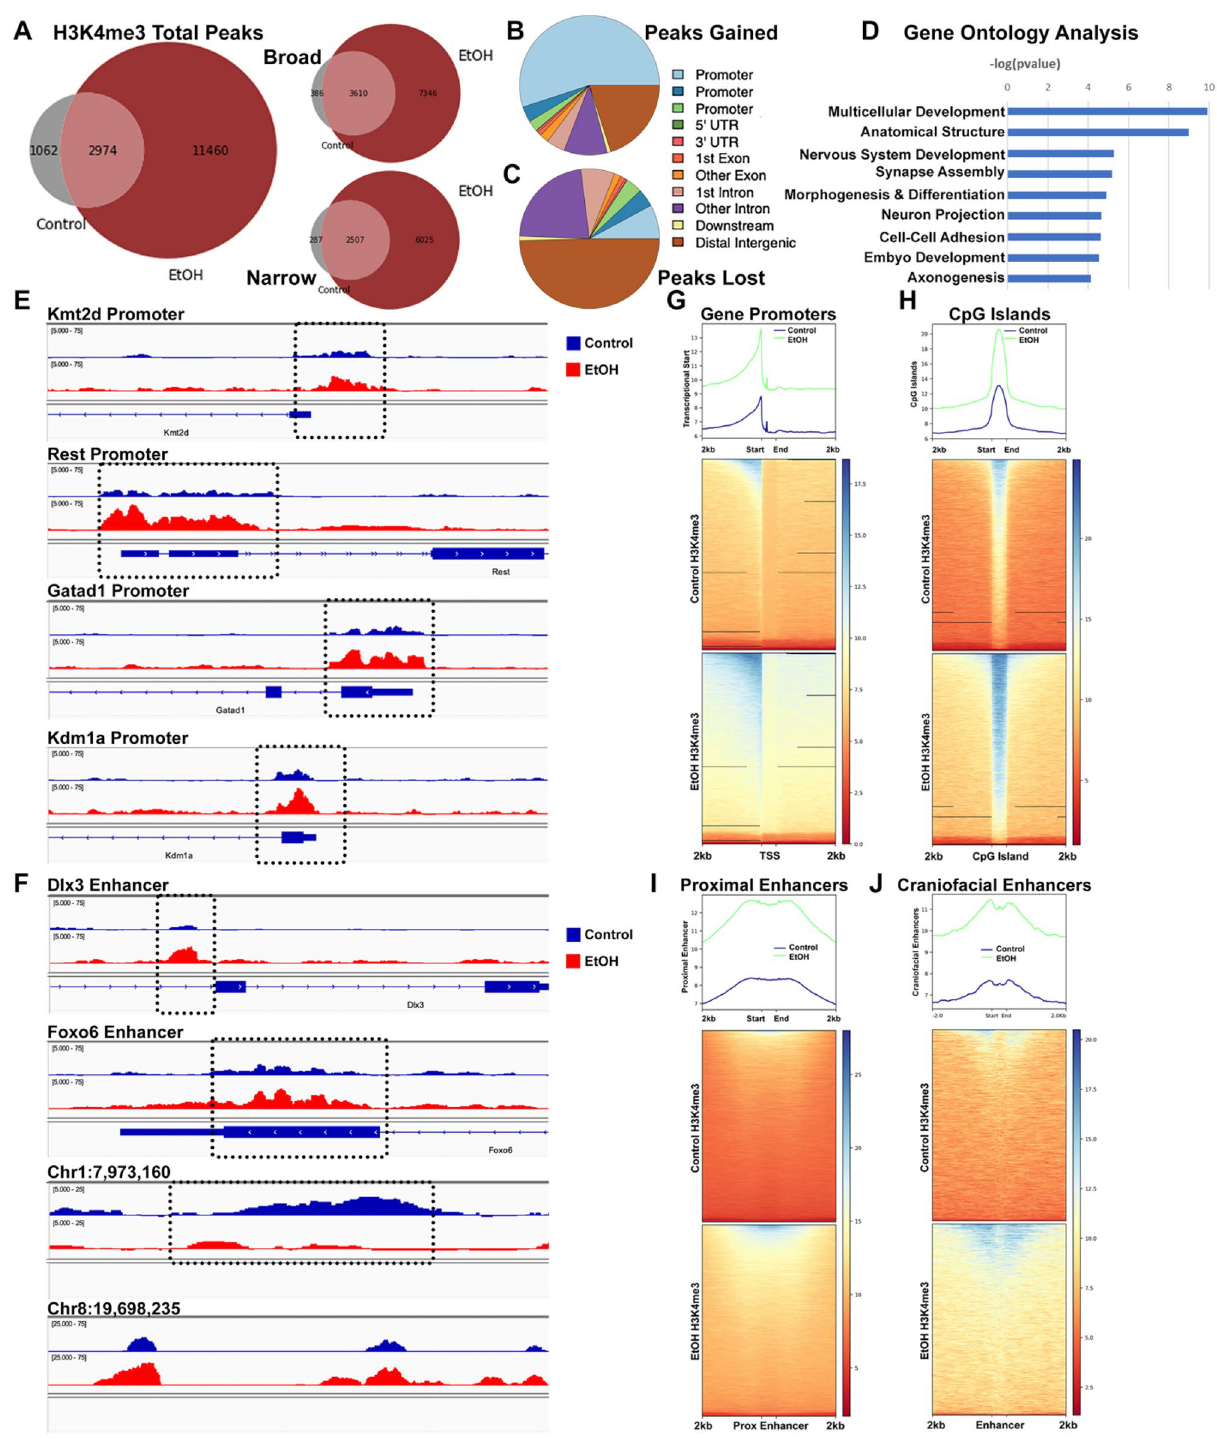
Figure 1. Chronic alcohol consumption increases H3K4me3 enrichment within the promoter and regulatory regions of critical developmental regulators. ( A ) Venn diagrams comparing total, broad, and narrow H3K4me3- enriched peaks between sperm isolated from control and EtOH-exposed males. Distribution of genomic regulatory features in ( B ) peaks gained and ( C ) lost in alcohol-exposed sperm. ( D ) Gene ontology analysis of peaks gained in alcohol-exposed sperm. Integrative Genome Viewer tracks showing altered H3K4me3 within the ( E ) promoter or ( F ) putative enhancer regions of genes involved in embryo development . Heatmaps displaying enrichment of H3K4me3 signals across ( G ) gene transcriptional start sites, ( H ) CpG islands, ( I ) ENCODE proximal enhancer elements 40 , and ( J ) gene enhancers regulating mouse craniofacial development 41 . We conducted ChIP-seq analysis on sperm isolated from 3 control and 4 EtOH-exposed males (n = 3,